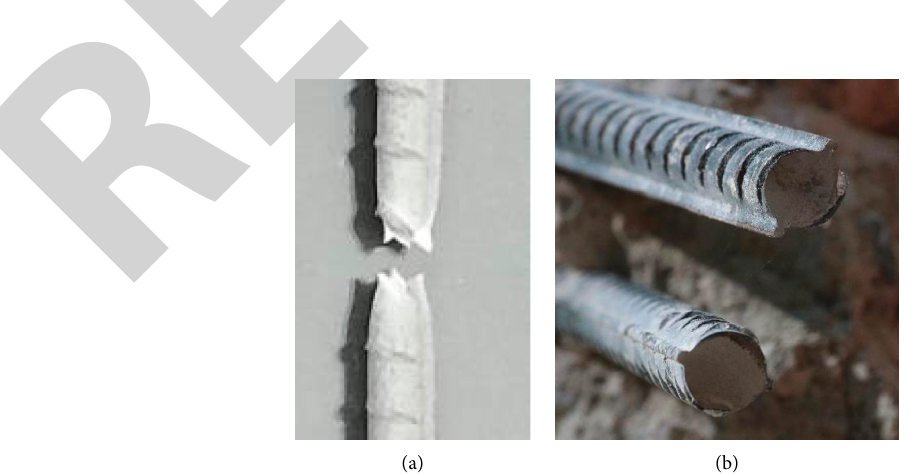
Figure 5: Fracture morphology comparison between different rebar failure modes. (a) Rebar yield failure. (b) Rebar fatigue failure.